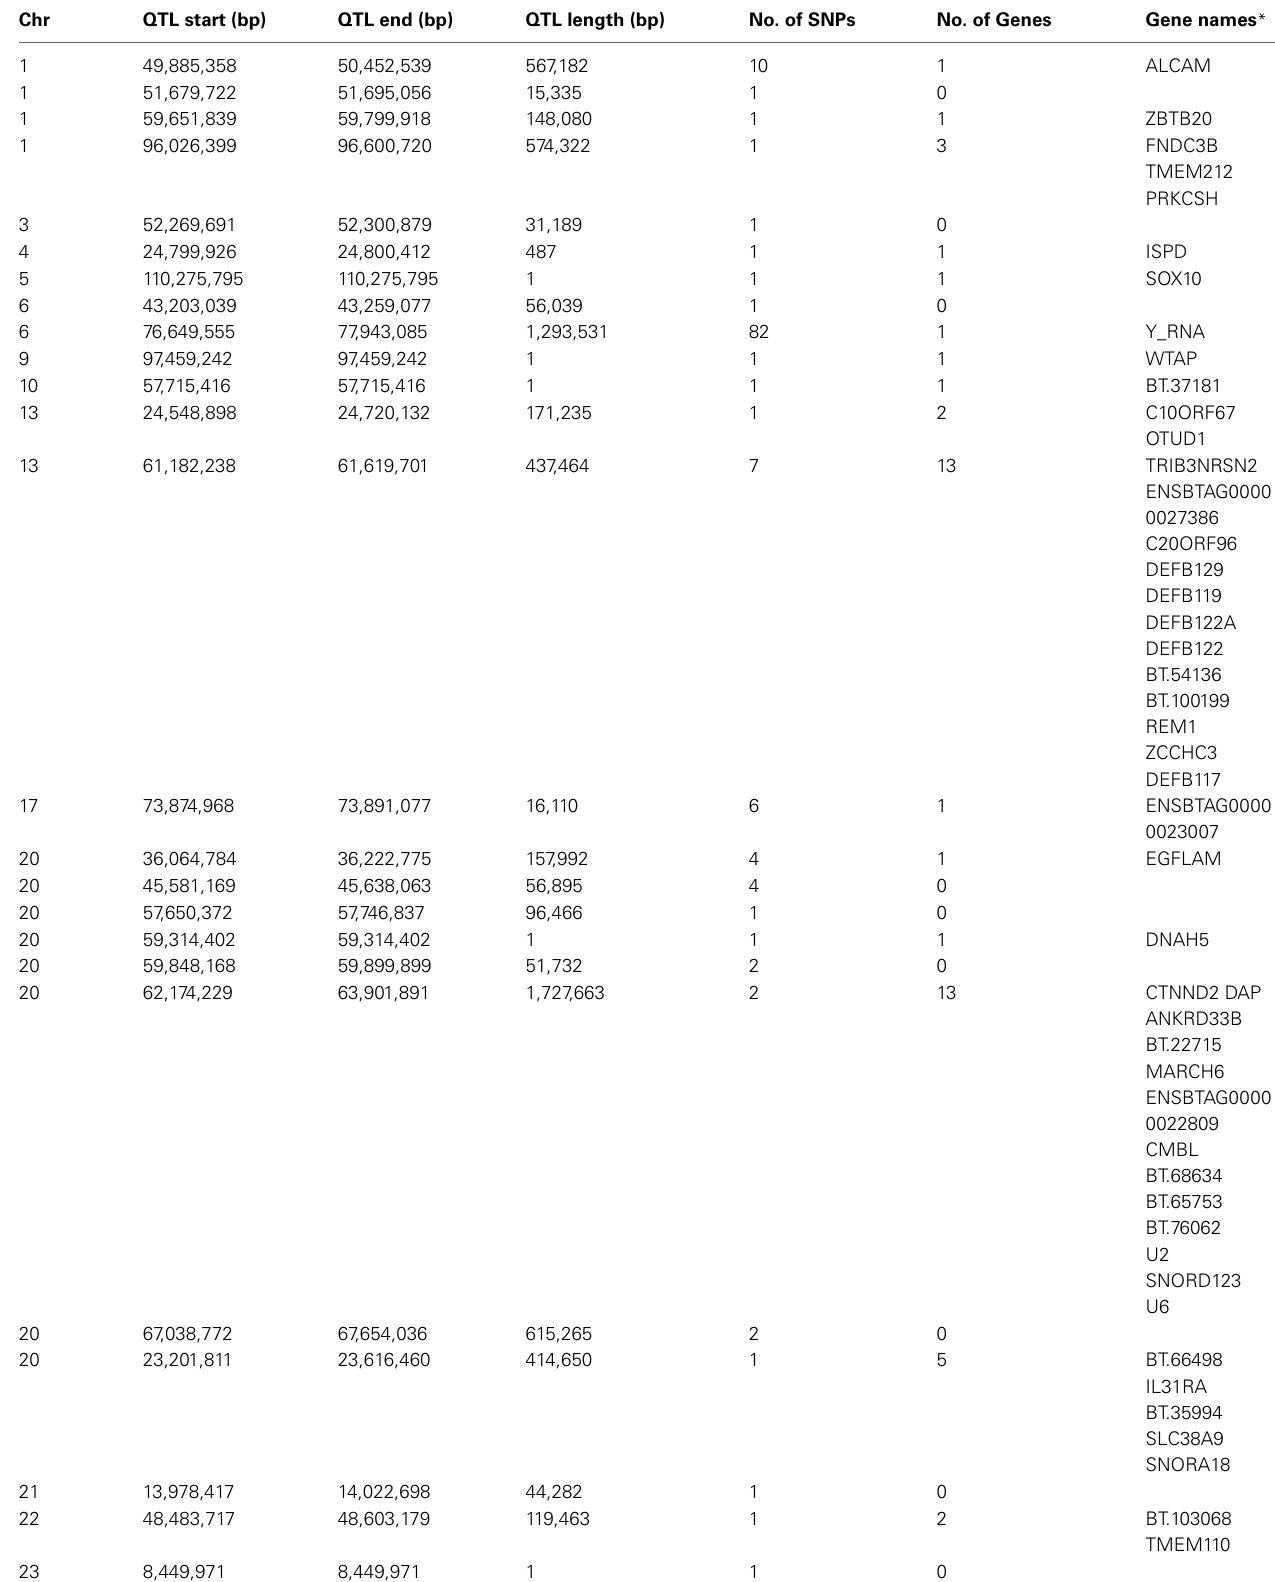
Table 1 | QTL regions identified for